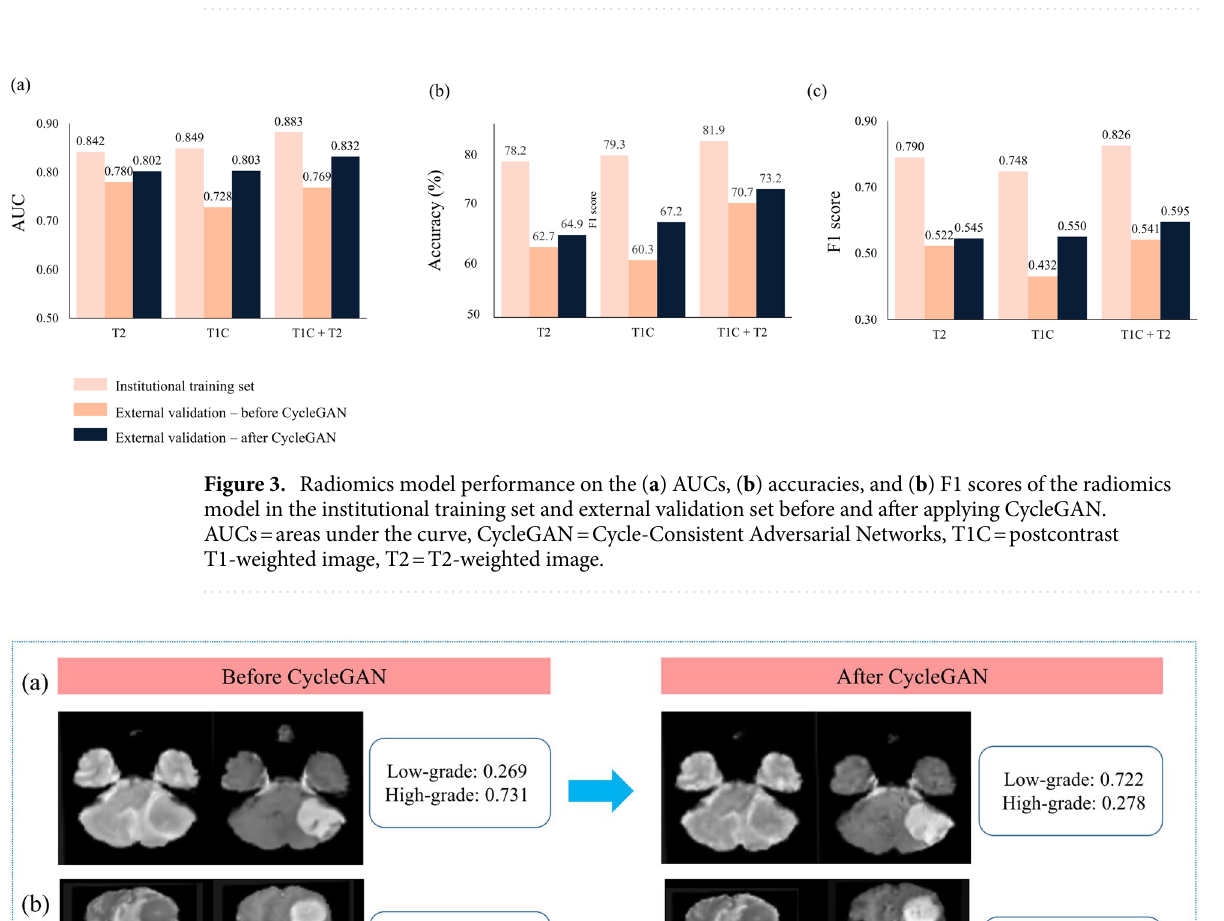
Table 2. Model performance on institutional training set and external validation set before and after applying CycleGAN. AUC = area under the curve, CI = confidence interval, CycleGAN = Cycle-Consistent Adversarial Networks, T1C = postcontrast T1-weighted image, T2 = T2-weighted image.